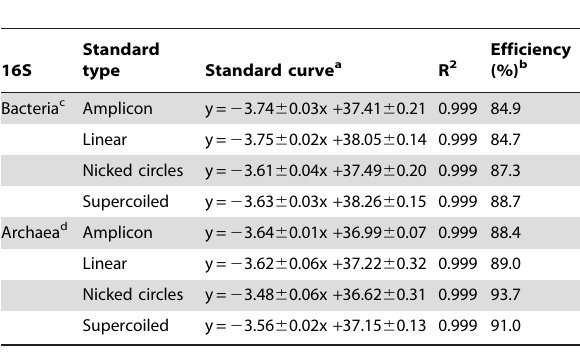
Table 3. Performance of microbial standard DNA in qPCR